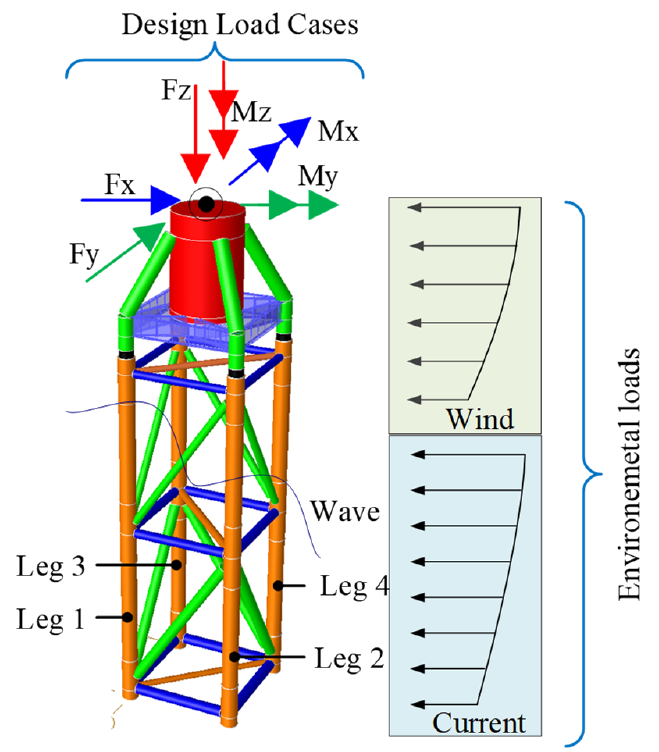
Figure 6. Loads acting on the 4-leg jacket substructure.